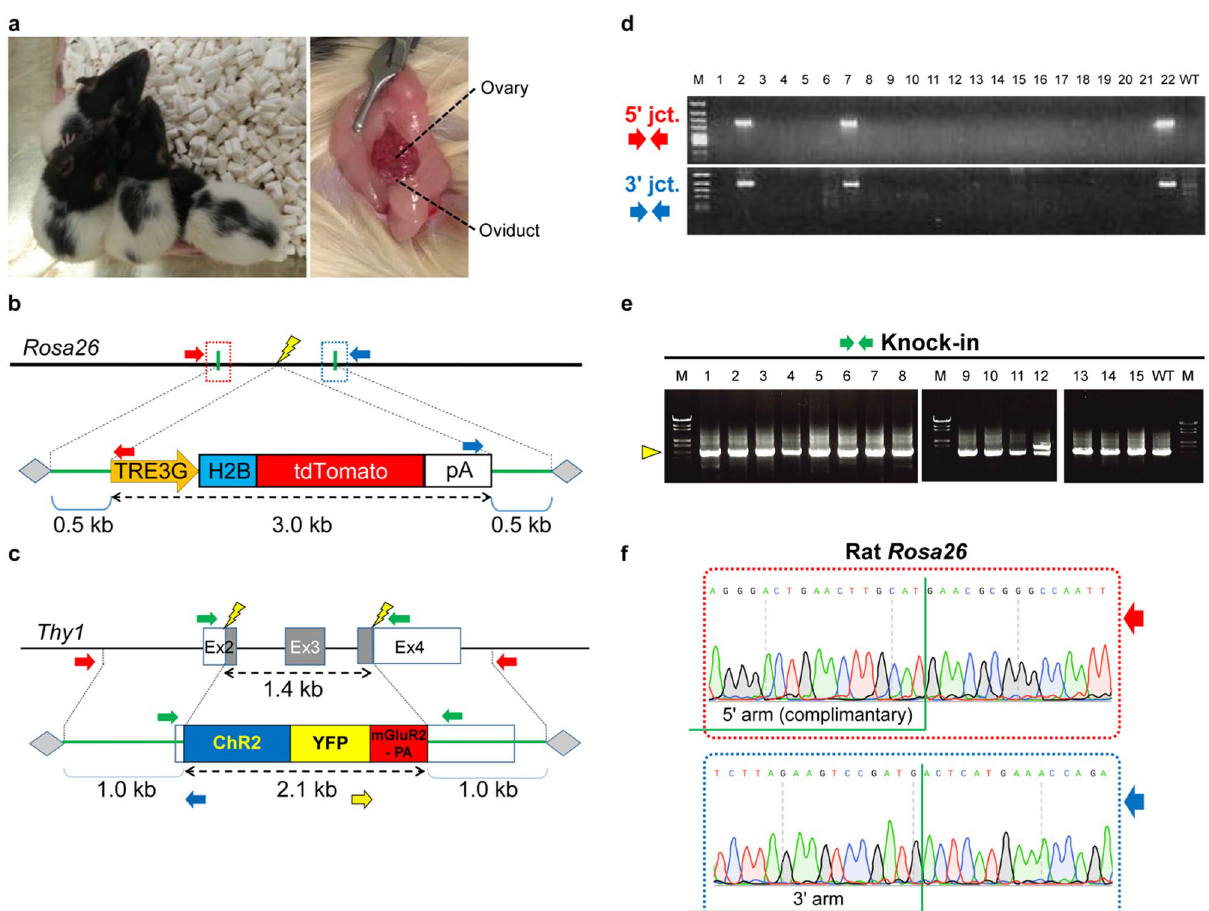
Figure 3. Generation of knock-in rats carrying a gene cassette by in situ electroporation of AAV1 donors. ( a ) Left, Establishment of a breeding colony of LH rats for in situ electroporation; right, the exposed ovary and oviduct of the rat. ( b , c ) Schematic of strategy to insert a tetO-H2B-tdTomato or a ChR2-YFP-mGluR2-PA cassette into endogenous rat Rosa26 or Thy1 locus, respectively. TRE3G, the third generation of tetracycline operator (tetO) sequence; H2B, histone H2B. Arrows indicate the PCR primers. ( d , e ) Confirmation of insertion using PCR. Three Rosa26 knock-in heterozygous LH rats (No. 2, No. 7, and No. 22) (in d ), and one Thy1 knock-in heterozygous LE rat (No. 12) (in e ) were obtained. 5 ′ expected band size: 0.7 kb; 3 ′ expected band size: 0.8 kb in ( d ). Knock-in expected band size: 2.5 kb; wild-type expected band size: 1.8 kb (yellow triangle) in ( e ). M, ϕX174- Hinc II digested (in d ) or λ- Sty I digested (in e ) DNA marker; WT, wild-type rats. (Supplementary Fig. S7,S8). The cropped gel images were grouped from different parts of the same image in e. ( f ) Representative sequencing chromatograms for correctly edited tetO-H2B-tdTomato knock-in